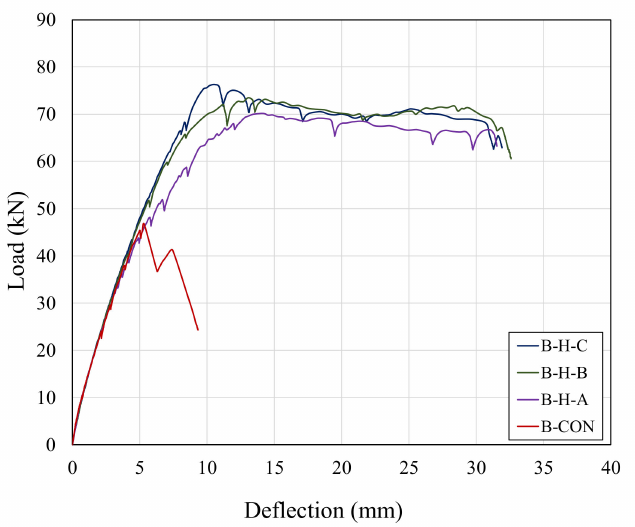
Figure 13. Load-deflection curves of the control and hemp FRRP composite strengthened beams.